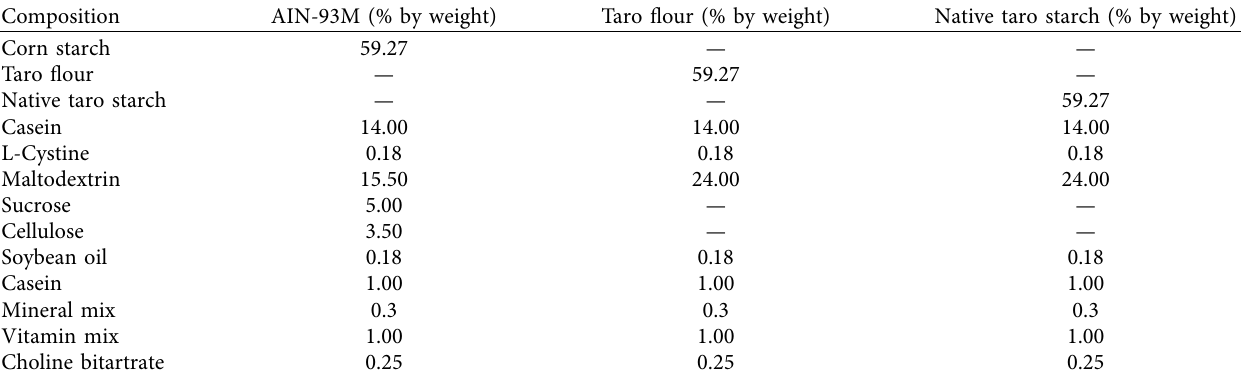
Table 1: Composition of different